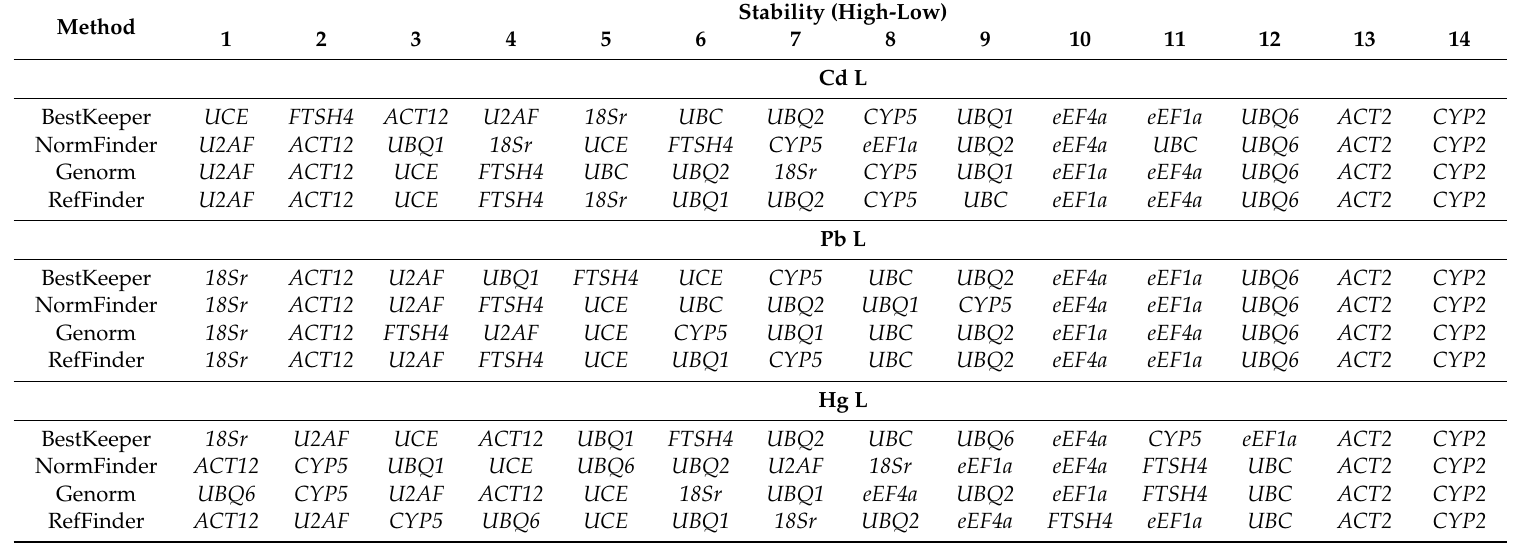
Table 3. The most stable and least stable combination of reference genes based on RefFinder